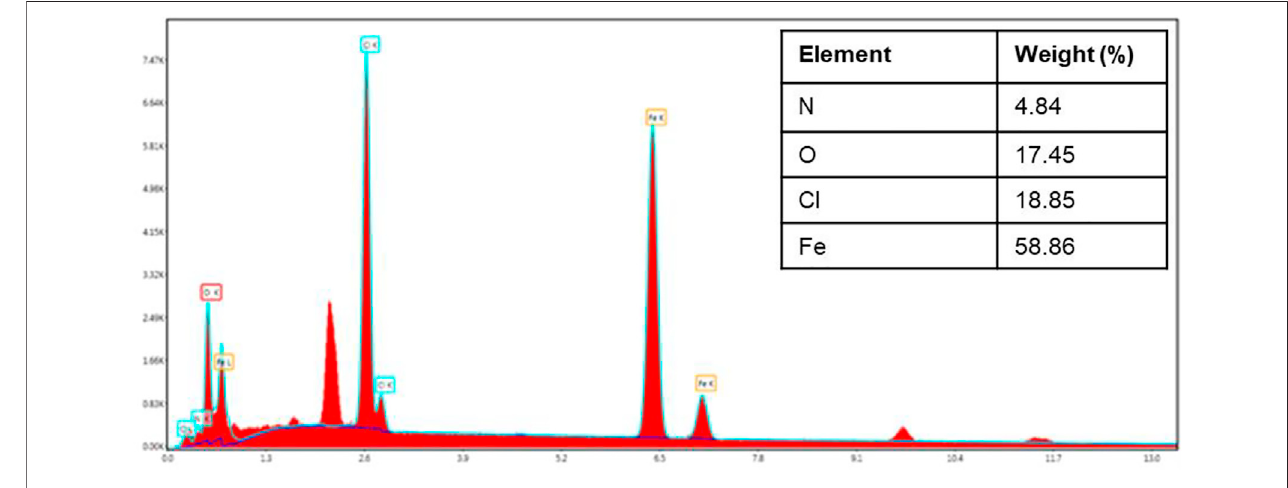
FIGURE 3 | SEM-EDX images of synthesized FeO-NPs.